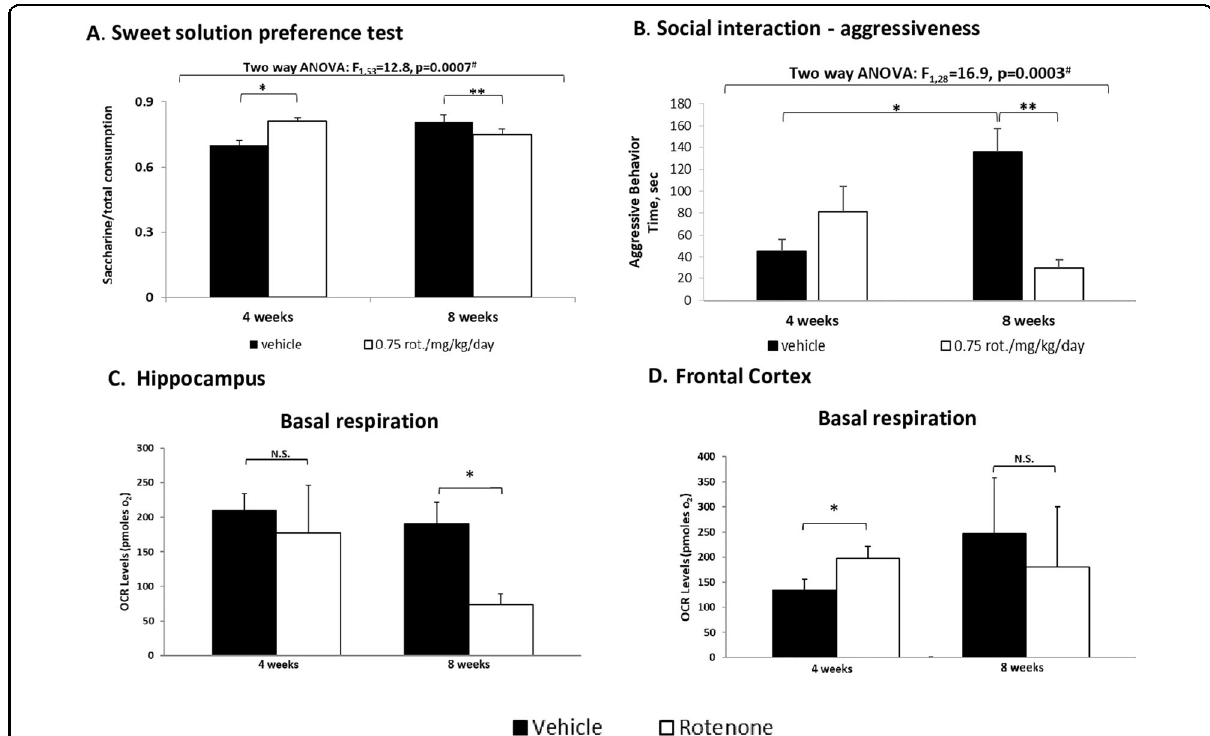
Fig. 4 Sweet solution preference test, aggressive behavior, and brain mitochondrial basal respiration of mice following in vivo rotenone- induced mild MD. Rotenone (0.75 mg/kg/day) was administered i.p. for 4 or 8 weeks. Lithium (Li) was given for the last 2 weeks of rotenone treatment. Results represent means±SEM of 12 mice/group. One result of the SSPT and one result from the basal respiration data which exceeded ±2SDs were excluded. A The effect in the SSPT. The amount of saccharine/total fl uids drank was signi fi cantly increased following 4 weeks of treatment and signi fi cantly decreased following 8 weeks. Two-way ANOVA with treatment (±Rot.) and duration of treatment (4/8 weeks) as main factors: # values are of the TreatmentXDuration interaction; Fisher ’ s LSD post hoc test: *4/8 weeks of Rot. vs. vehicle, p < 0.02. B The effect on aggressiveness. Time spent in aggressive behavior was 1.8-fold non-signi fi cantly increased following 4 weeks of treatment and 4.6-fold signi fi cantly decreased following 8 weeks. Two-way ANOVA with treatment (±Rot.) and duration of treatment (4/8 weeks) as main factors: # values are of